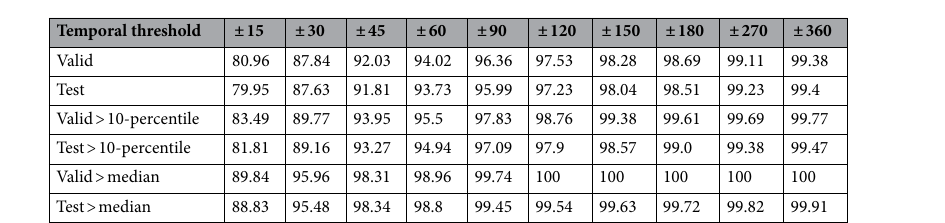
Table 1. Phase transition accuracy. Evaluating the effect of small temporal shifts in phase start time. Testing whether a predicted phase transition occurs within a temporal threshold (in seconds) of the true transition. Numbers state the percentage of phases within the threshold. The first two rows are showing all valid and test videos, the last two rows are showing only a subset of videos with per-video accuracy greater than the videos median accuracy and the middle two rows are done on a subset without including the bottom 10%